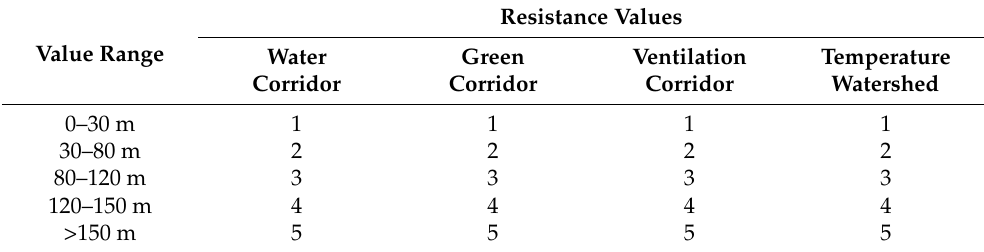
Table 1. Resistance factors and resistance